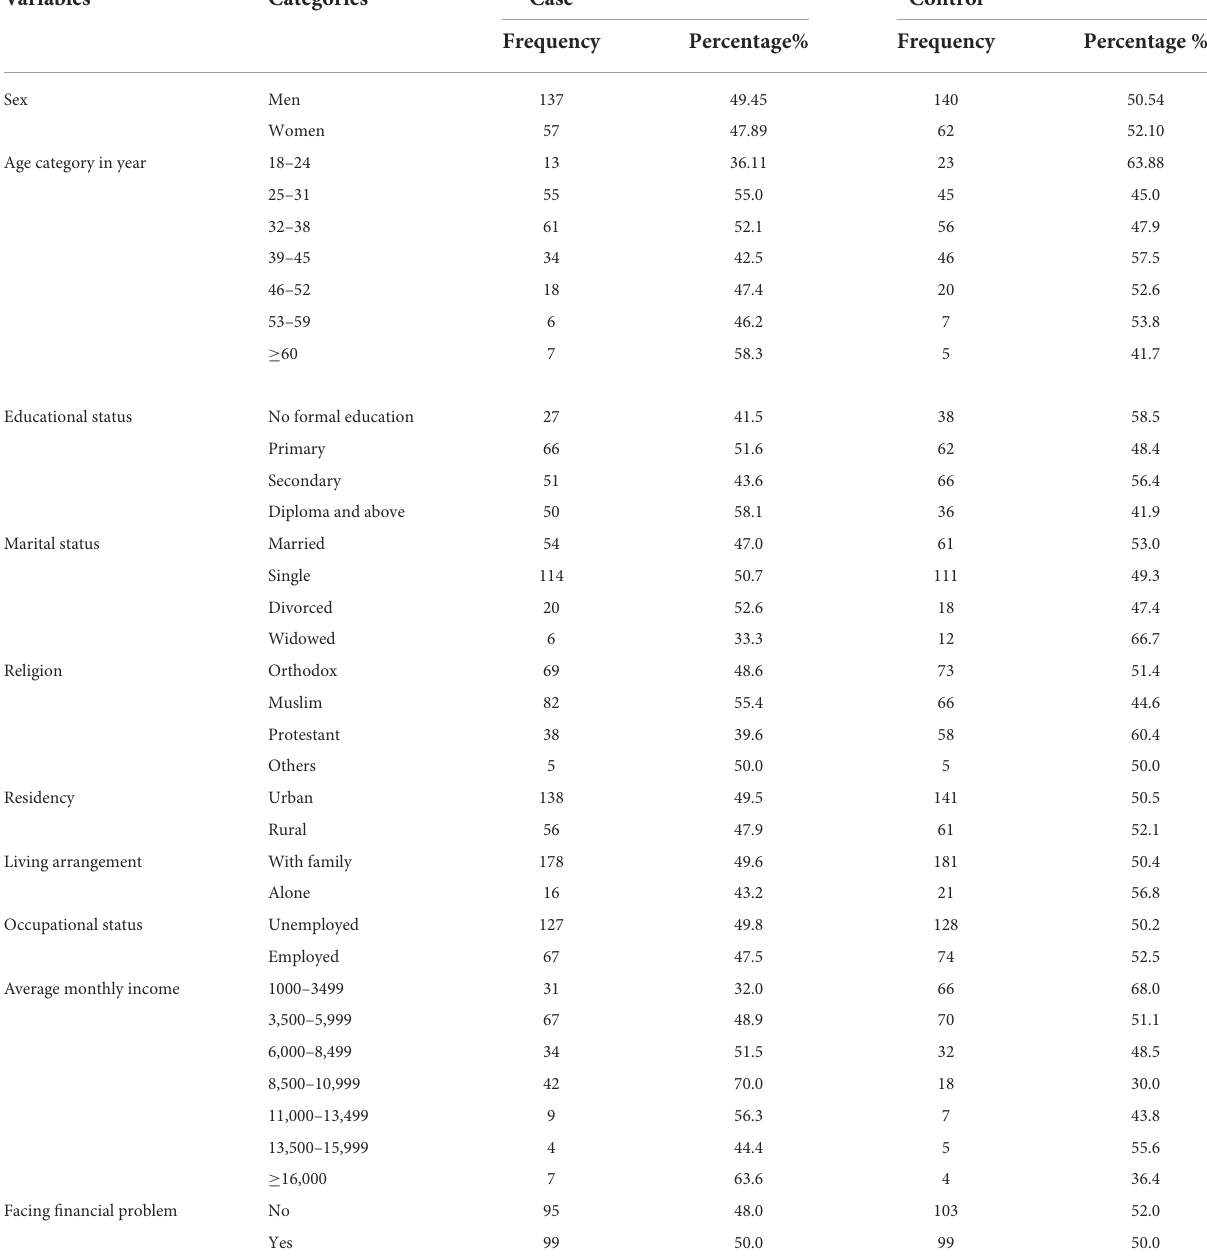
TABLE 1 Sociodemographic characteristics of patients with schizophrenia at the Amanuel Mental Specialized Hospital, Addis Ababa, Ethiopia ( n =